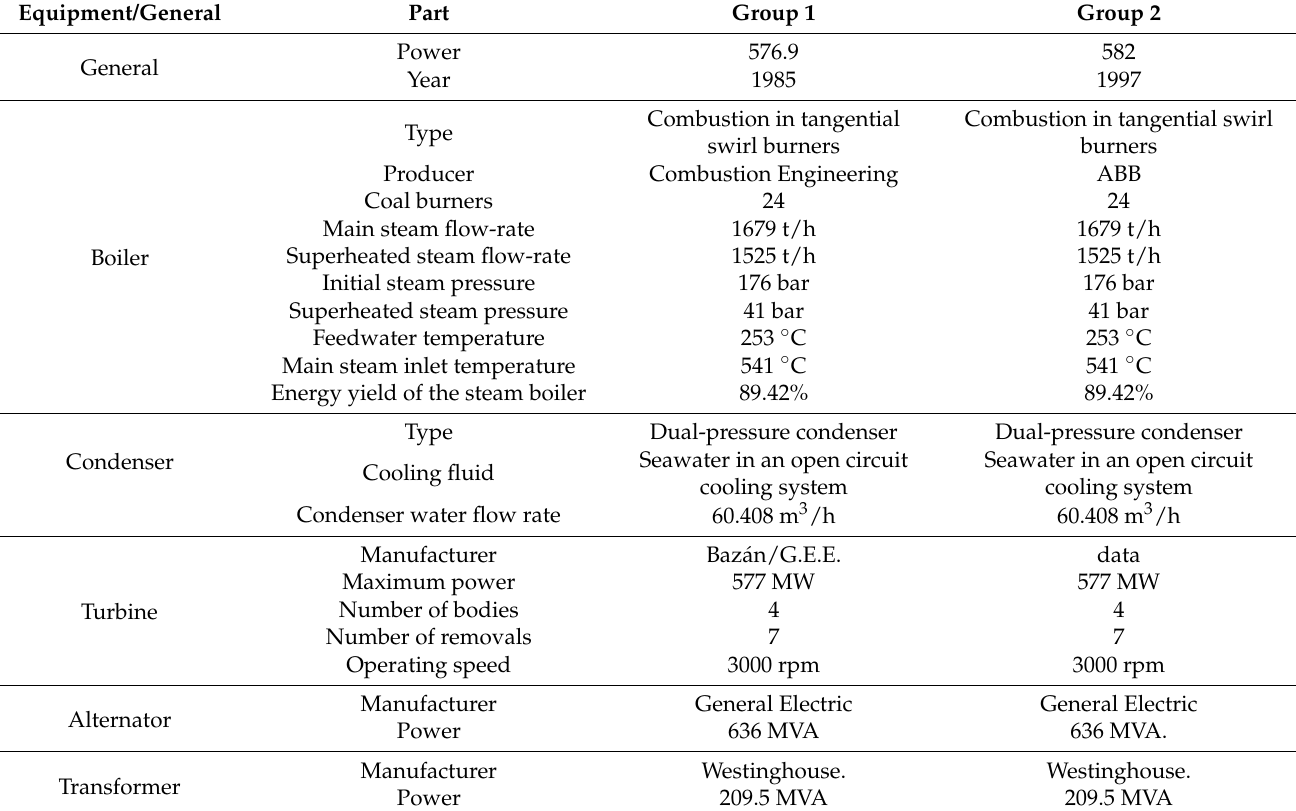
Table 3. Data with regard to the power station.